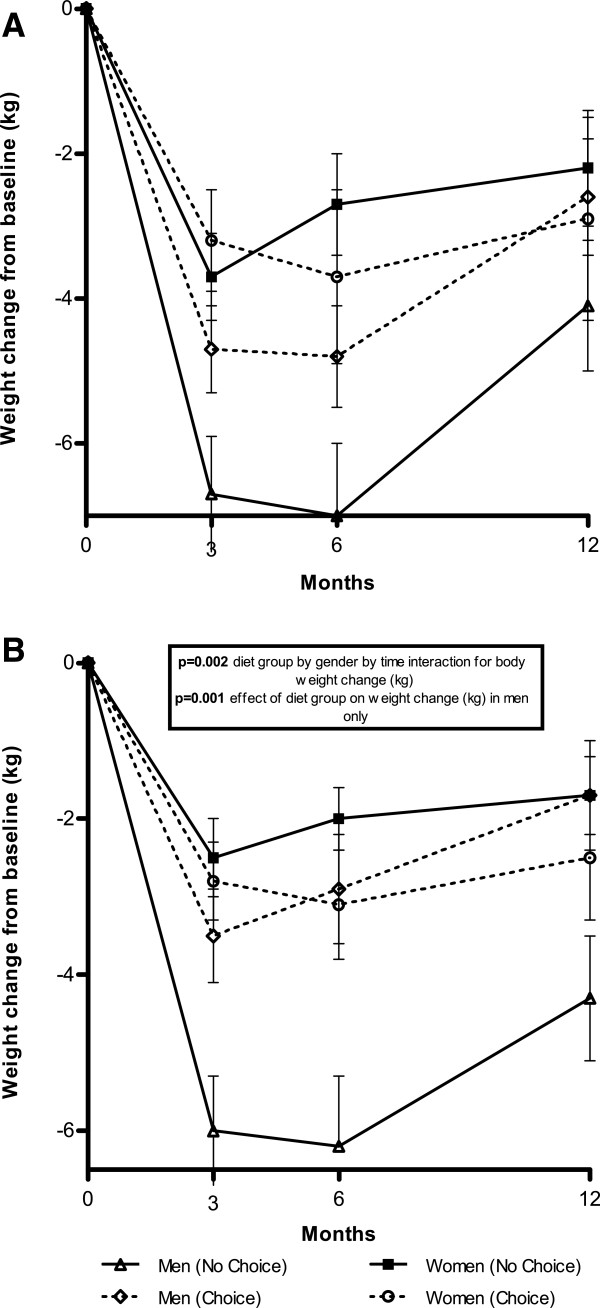
Weight change (kg) from baseline by diet group and gender. A. Shows only those participants who completed the 12 month weight loss program. B. Shows weights for all participants enrolled at baseline with weights carried forward from last known measurement for participants who discontinued the weight loss program. Data are means, error bars represent SE. P-values determined using repeated measures ANOVA. Participant numbers were: A. No Choice – women (n = 21) and men (n = 28); Choice - women (n = 18) and men (n = 29); and B. No Choice – women (n = 35) and men (n = 38); Choice women (n = 31) and men (n = 40).